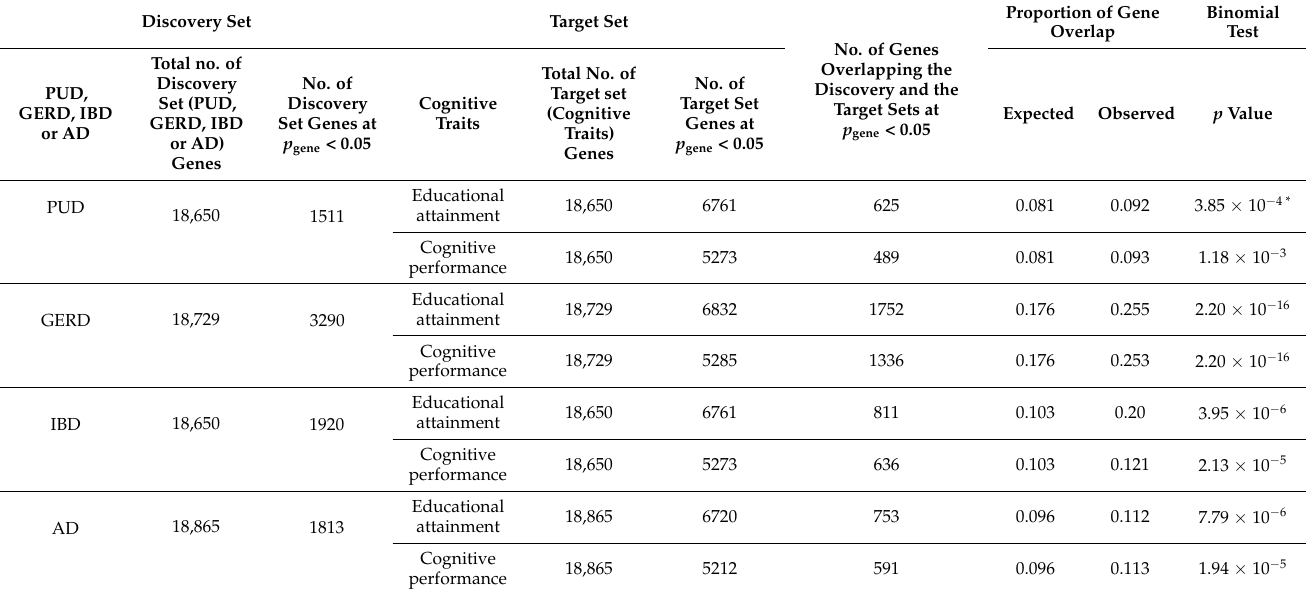
Table 7. Gene-level genetic overlap of cognitive traits with PUD, GERD, IBD, and AD. Discovery Set Target